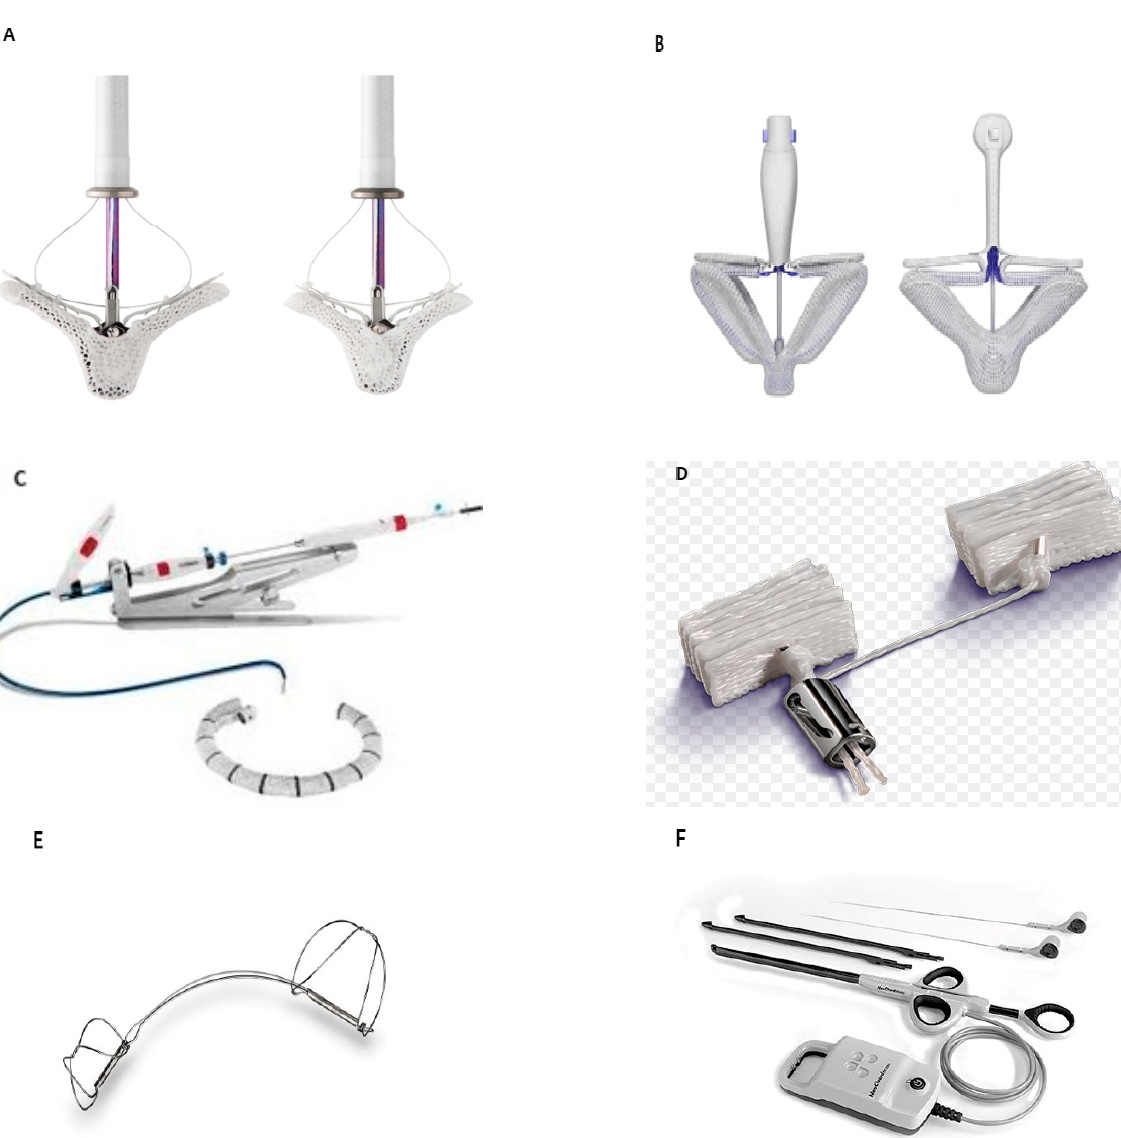
Figure 1. Transcatheter Mitral Valve Repair Systems: ( A ) MitraClipTM device. Image courtesy of Abbott. ( B ) PASCAL system. Image courtesy of Edwards Lifesciences. ( C ) Cardioband system. Image courtesy of Edwards Lifesciences. ( D ) Mitralign system. Image courtesy of Mitralign Inc. ( E ) Carillon mitral contour system. Image courtesy of Cardiac Dimensions. ( F ) NeoChord system. Image courtesy of NeoChord Inc.